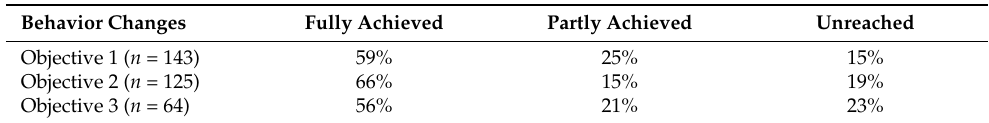
Table 3. Achievement of health-related behavior objectives at day 90 (143 answers; 2 dropouts and 5 patients preferring not to set